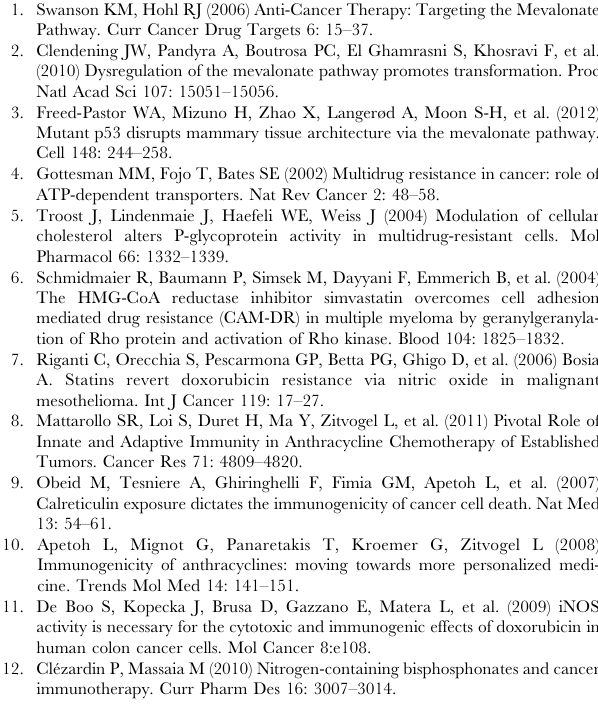
Figure S3 CD86 expression on DC surface after inter- nalization of MDR + HT29-dx tumor cells. The CD86 expression was evaluated on DC surface in the immature status and after internalization of ZA and/or Dox-treated HT29-dx cells. The internalization of ZA + Dox treated-HT29dx cells induced an up-regulation of CD86 expression, in line with the concept that the exposure of DCs to Dox-treated tumor cells stimulates their maturation. The results represent the mean 6 SD of 6 independent experiments. (TIF) Figure S4 Cytotoxic activity of T cells against MDR + HT29-dx tumor cells. The cytotoxic activity exerted by T cells against MDR + HT29-dx tumor cells was evaluated after incubation with autologous DCs pulsed with medium alone (CTRL), ZA, Dox and ZA + Dox-treated HT29-dx cells. Cytotox- icity was evaluated by CFSE staining of tumor target cells identifying the CFSE-labeled dead cells by propidium iodide. The highest cytotoxic activity was observed after T-cell stimulation by DCs loaded with HT29-dx cells exposed to ZA plus Dox. The results are from one experiment.